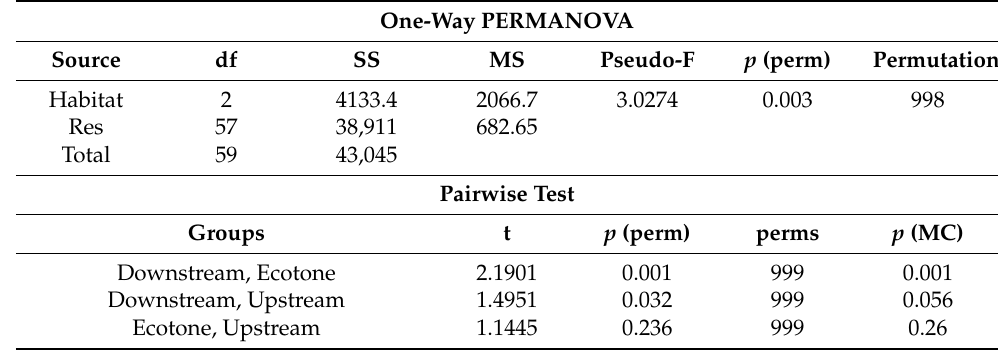
Table 3. Results of one-way PERMANOVA test for meiofaunal community